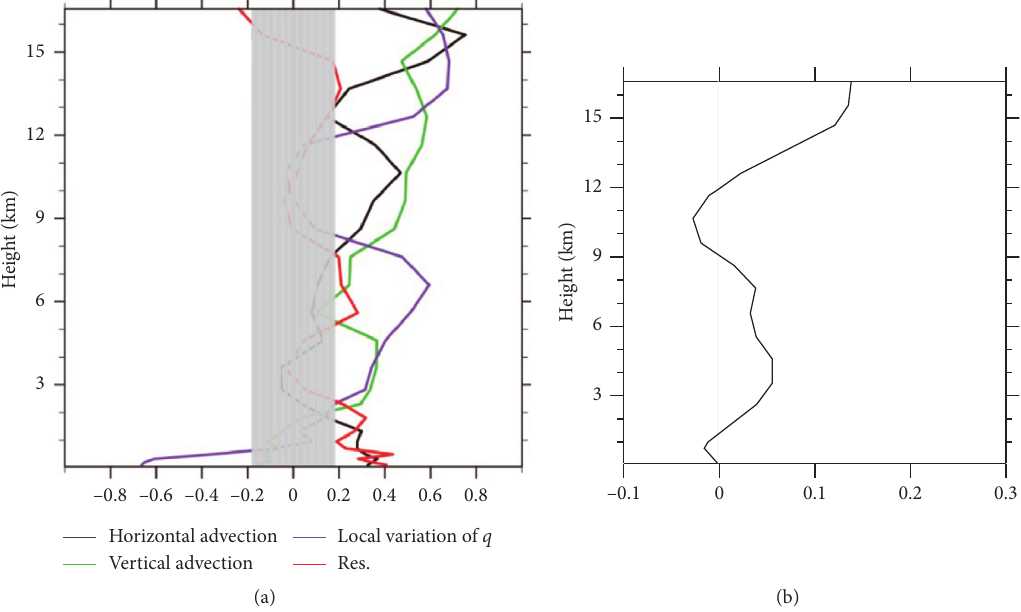
Figure 13: (a) Correlation coefficients between θ v tendency and the contribution of horizontal advection (including SH and LH; − ( u · z θ z φ +( θ L T · u z q / r z φ − ( v · z θ z r +( θ L T · v z q / z r ); black), the contribution of vertical advection v / r v v,s,f )/( C pd v ) v / v v,s,f )/( C pd v ) (including SH and LH; − w · z θ v / z z − ( θ v L v,s,f )/( C pd T v ) · w z q / z z ; green), LH from the local variation of q ( − ( θ v L v,s,f )/( C pd T v ) · z q / z t ; purple), and the residual term (red), calculated using the 200 sets of data of the four cycles. Areas outside the gray mask indicate statistical significance at the 99% confidence level. (b) Variation of the averaged θ v tendency with